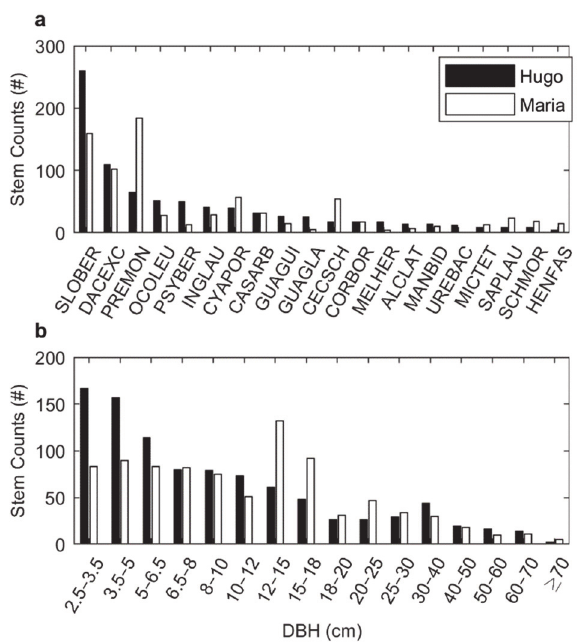
Figure 4. Species composition and size structure present before hurricane Hugo and before hurricane María at BEW. ( a ) Stem counts of the most abundant species and ( b ) distribution of each DBH size. The code and name of each species in ( a ) are in Table S1. The two distributions in each panel are significantly different at 99% level ( p < 0.0001) using χ 2 test.